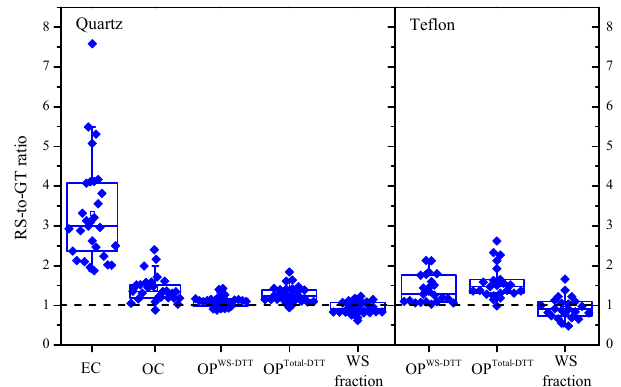
Figure 9. Comparison of simultaneous measurements at GT and RS sites based on daily RS-to-GT concentration ratios. The bottom and top of the box are the first (Q1) and third quartiles (Q3), and the band inside the box is the median. The lowest and highest ends of whisker are (Q1–1.5IQR) and (Q3 + 1.5IQR), where the interquar- tile range (IQR) =